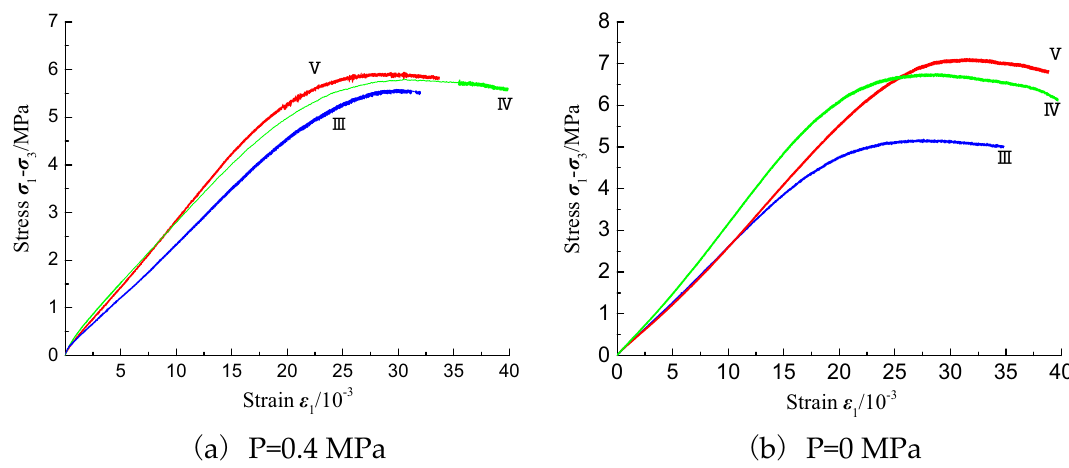
Figure 13. Stress–strain curves of class III–V coal samples under different pore pressures and triaxial compression.